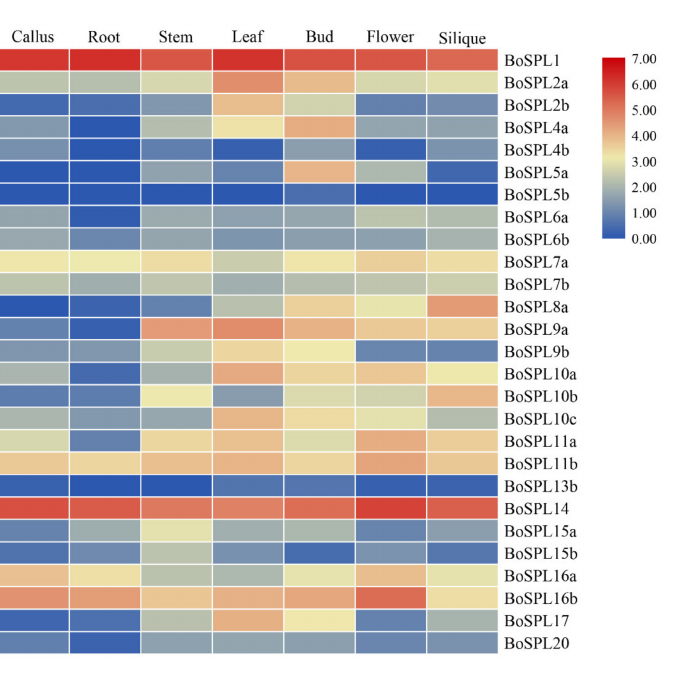
Figure 6. Expression profiles of BoSPL genes. Heat map representation of BoSPL genes in various organs/tissues, included callus, roots, stems, leaves, buds, flowers and siliques. Expression levels of the BoSPL genes are shown as the log 2 (FPKM+1), transformed FPKM values obtained from the RNA-Seq